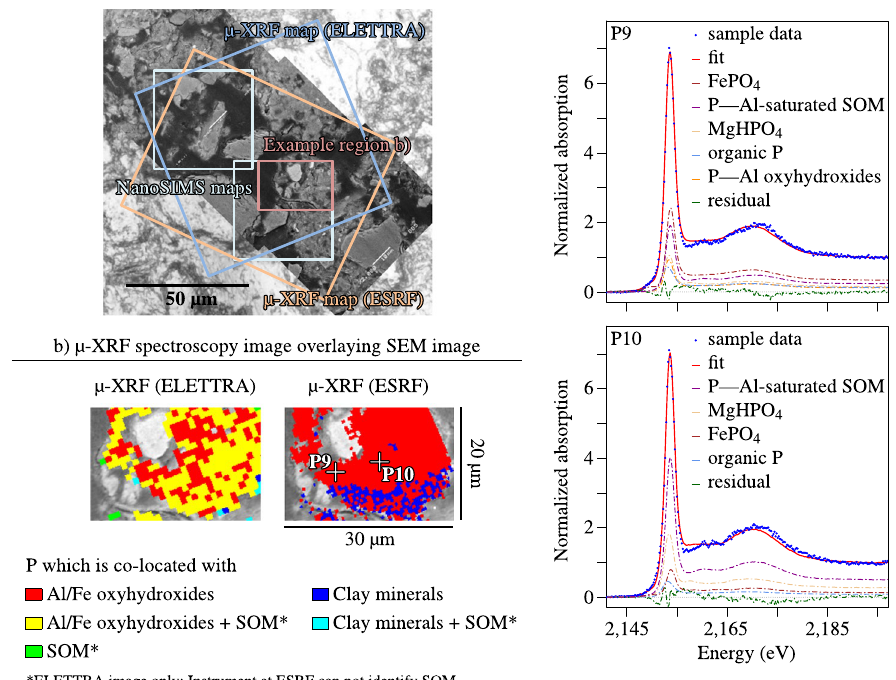
Figure 2. Example of micro-scale X-Ray Fluorescence ( μ -XRF) and X-Ray Absorption Near Edge Structure ( μ -XANES) spectroscopy. ( a ) Scanning electron microscope (SEM) (back scattered electron) images overlaying light microscope image of the soil aggregate from the high-Phosphorus (P) topsoil, raster imaging regions of Nanoscale Secondary Ion Mass spectrometry (NanoSIMS) and μ -XRF mapping, indicated as rectangles, ( b ) exemplary detail of μ -XRF mapping results obtained at ELETTRA and ESRF from P-rich areas, ( c ) two μ -XANES spectra from selected P micro-sites (P9 and P10, ESRF) with the linear combination fit, and calculated shares of P